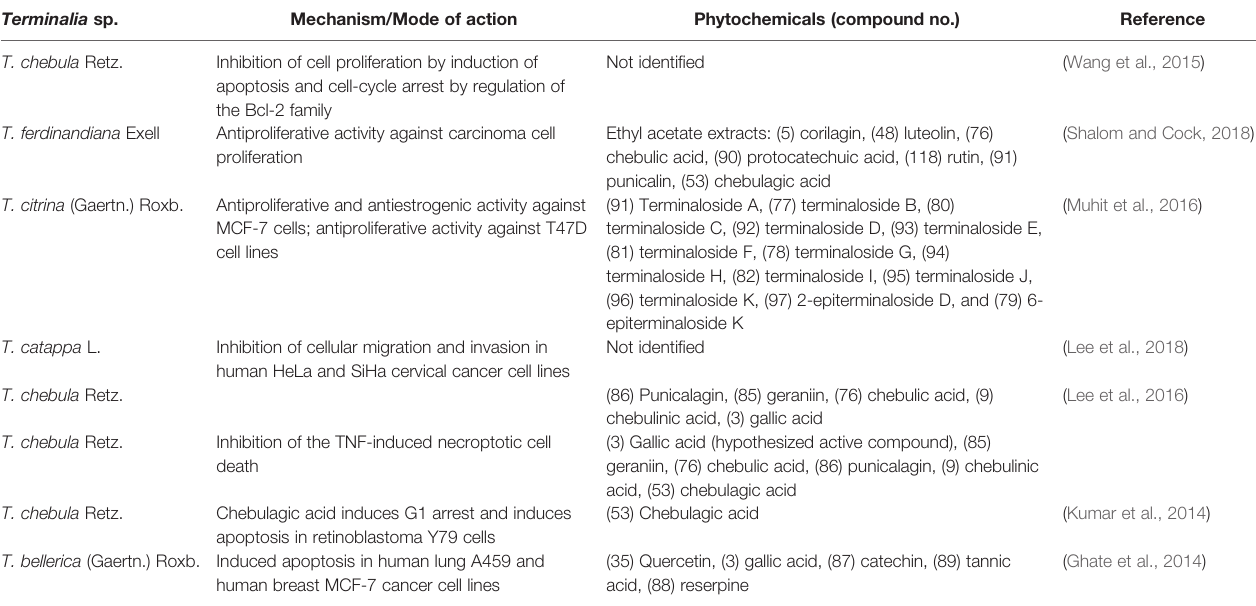
TABLE 4 | Summarization of the anticancer studies with different Terminalia species. Terminalia